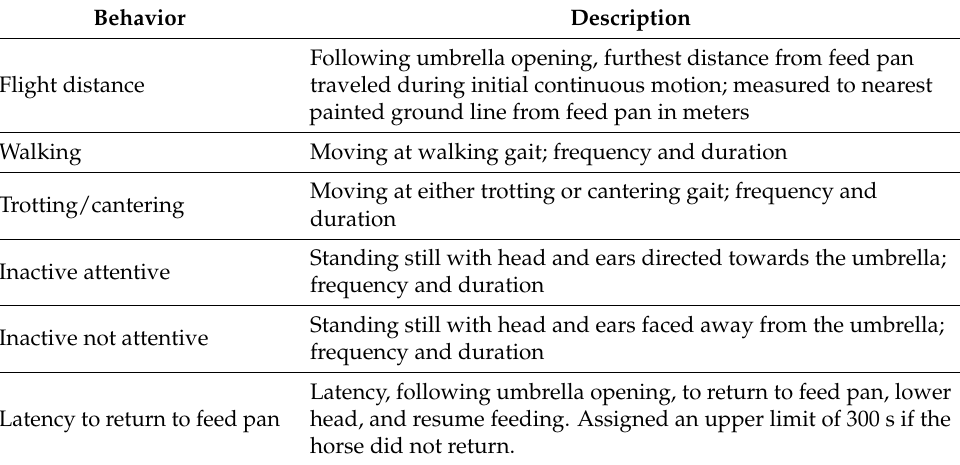
Table 1. Ethogram of behaviors observed through video recorded during the startle